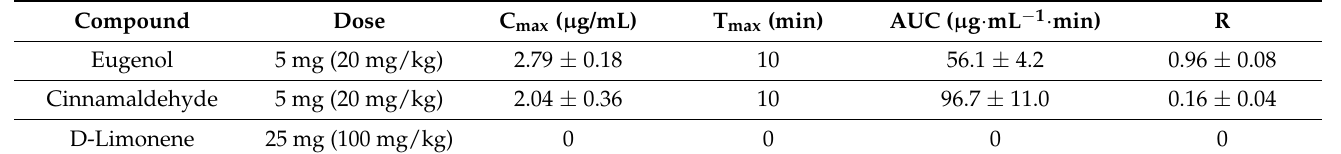
Figure 4. Cinnamaldehyde concentrations ( µ g/mL) detected in the CSF of rats after intravenous administration of a 5 mg (20 mg/kg) dose. Data are expressed as the mean ± SE of four independent experiments. Table 2. Pharmacokinetic parameters referred to cerebrospinal fluid (CSF) of eugenol, cinnamalde- hyde and D-limonene after intravenous administration to rats. Data are reported as mean ± SE ( n = 4). C max : maximum concentration obtained in CSF; T max : time of C max ; AUC: area under concentration from the end of infusion to last time of detection; R: ratio of concentration between CSF and bloodstream at T max .